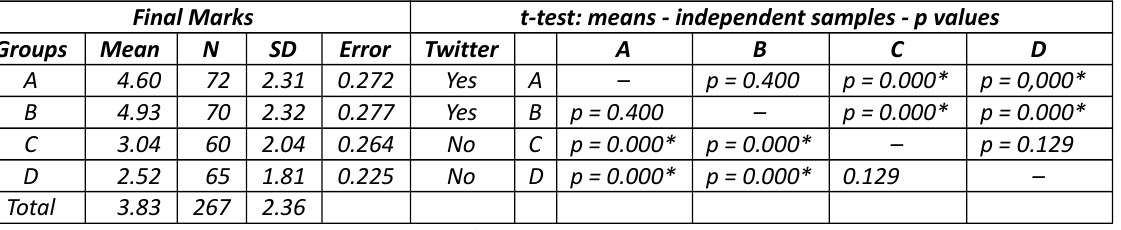
Table 7. Comparison of means t-test - independent